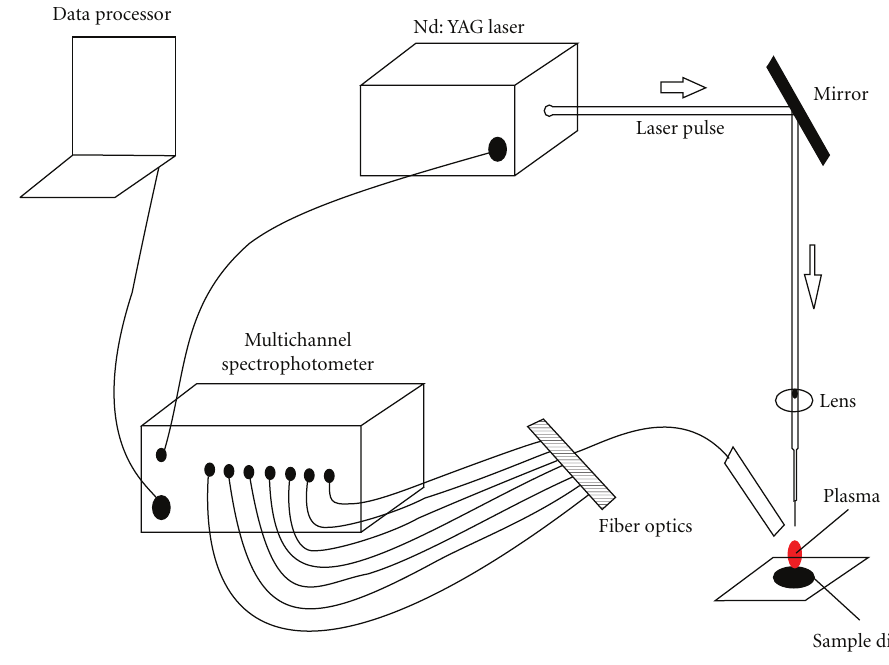
Figure 1: Schematic diagram of an LIBS2500plus system.